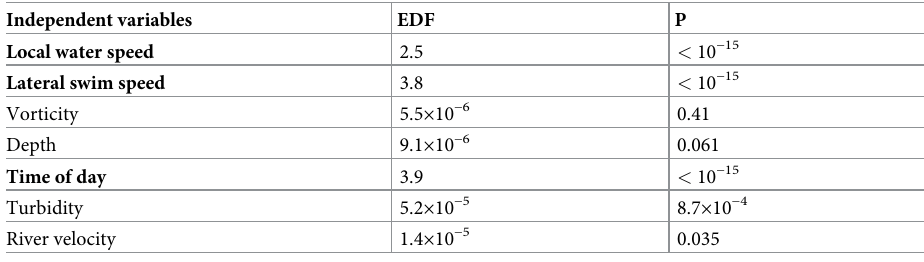
Table 3. Summary of GAM for longitudinal swimming